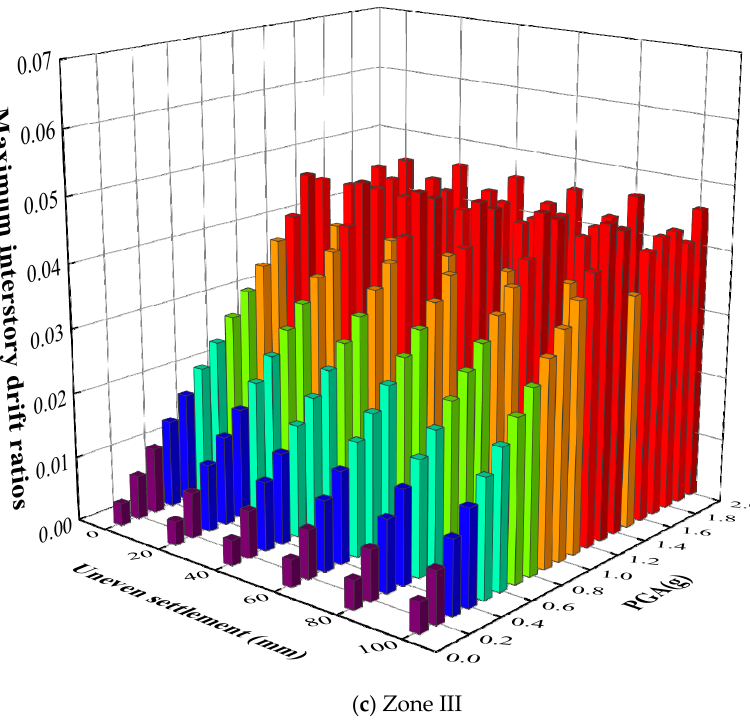
Figure 12. Influences of uneven settlement and ground motion intensity on structural response.